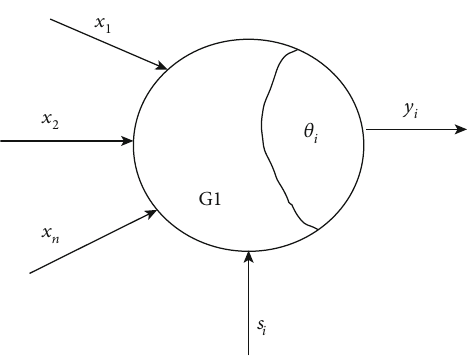
Figure 2: Neuron structure